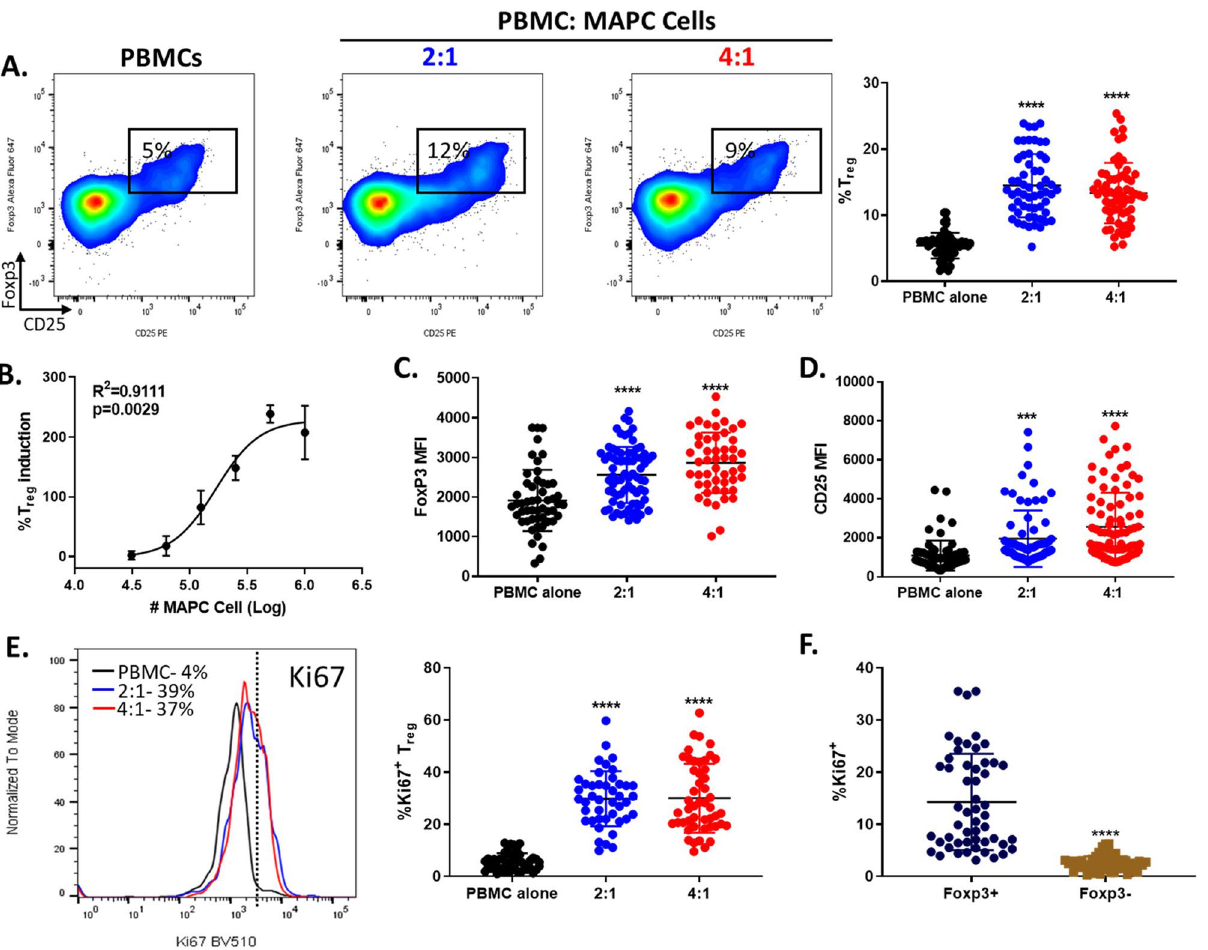
Figure 1. Co-culturing PBMCs and MAPC cells increase Treg frequency. ( A ) Representative dot plots depicting the percentages of Tregs (CD3 + CD4 + FoxP3 + CD25 + ) in PBMC alone and PBMCs co-cultured with MAPC cells for 7 days (2:1 and 4:1 PBMC:MAPC cell ratios). Graph shows quantification of MAPC cell dependent Treg induction. Each symbol represents one n from multiple independent experiments. ( B ) Dose dependent curve of Treg induction. Quantification of ( C ) FoxP3 and ( D ) CD25 MFI on Tregs. ( E ) Representative histogram depicting Ki67 expression on Tregs from PBMC (black line), 2:1 (blue line), and 4:1 (red line) co-cultures. FMO shown as dotted line. Numbers represent the percent Ki67 positive within the Treg population. Graph shows quantification of Ki67 expression on Tregs. Data represent mean ± SD from pooled samples of 16 independent experiments with 10 PBMC different donors and 3 different MAPC cell donors. P-values were determined by One-way ANOVA with a Tukey’s multiple comparisons test reference to the control PBMC alone (****p < 0.0001 and ***p < 0.001). ( F ) Ki67 expression on FoxP3 positive (navy) and FoxP3 negative (gold) population from 2:1 PBMC:MAPC cell co-cultures. P-value was determined by unpaired t T cell stimulation 27–29 . The percentage of Tregs (CD3 + CD4 + CD25 + FoxP3 + , see Supplemental Fig. 1 for gating strategy) was determined by flow cytometry at day 7 (Fig. 1). As seen in vivo, allogeneic MAPC cells increased the percentage of Tregs by approximately 2.7-fold at 2:1 and 2.5-fold at 4:1 PBMC:MAPC cell ratios, respectively (Fig. 1A). MAPC cell induction of Tregs was also assessed at day 4, 5, and 14. At day 4, co-culture of PBMCS with MAPC cells at 2:1 PBMC:MAPC cell ratio increased Tregs frequencies approximately 80% while no Treg induction was observed at 4:1 (Supplemental Fig. 2A). At day 5, MAPC cells also increased Treg frequencies in both 2:1 and 4:1 PBMC:MAPC cell ratios, however, maximum Treg induction was observed at day 7. Aug- mented cell death was observed after 14-day co-culture (data not shown). Given that in vivo studies have dem- onstrated that MAPC cells are undetected approximately 7 days after administration 20,30,31 and maximal MAPC cell mediated Treg induction was observed at day 7, induction of Tregs by MAPC cells was studied at day 7. Increased Treg counts were also observed after co-culture with MAPC cells at both day 5 and day 7 (Supplemen- tal Fig. 2B). Further dilutions of MAPC cell concentration demonstrated that MAPC cell induction of Tregs is dose dependent (Fig. 1B). Increased FoxP3 and CD25 expression on Tregs have been shown to correlate with increased anti-inflammatory capacity 32–34 . Thus, the FoxP3 and CD25 median fluorescent intensity (MFI) within the Treg population was examined (Fig. 1C,D). Interestingly, miTregs displayed increased FoxP3 and CD25 expression than Tregs from PBMCs cultured alone. Comparable to Tregs, miTregs were Helios positive (~ 80%)